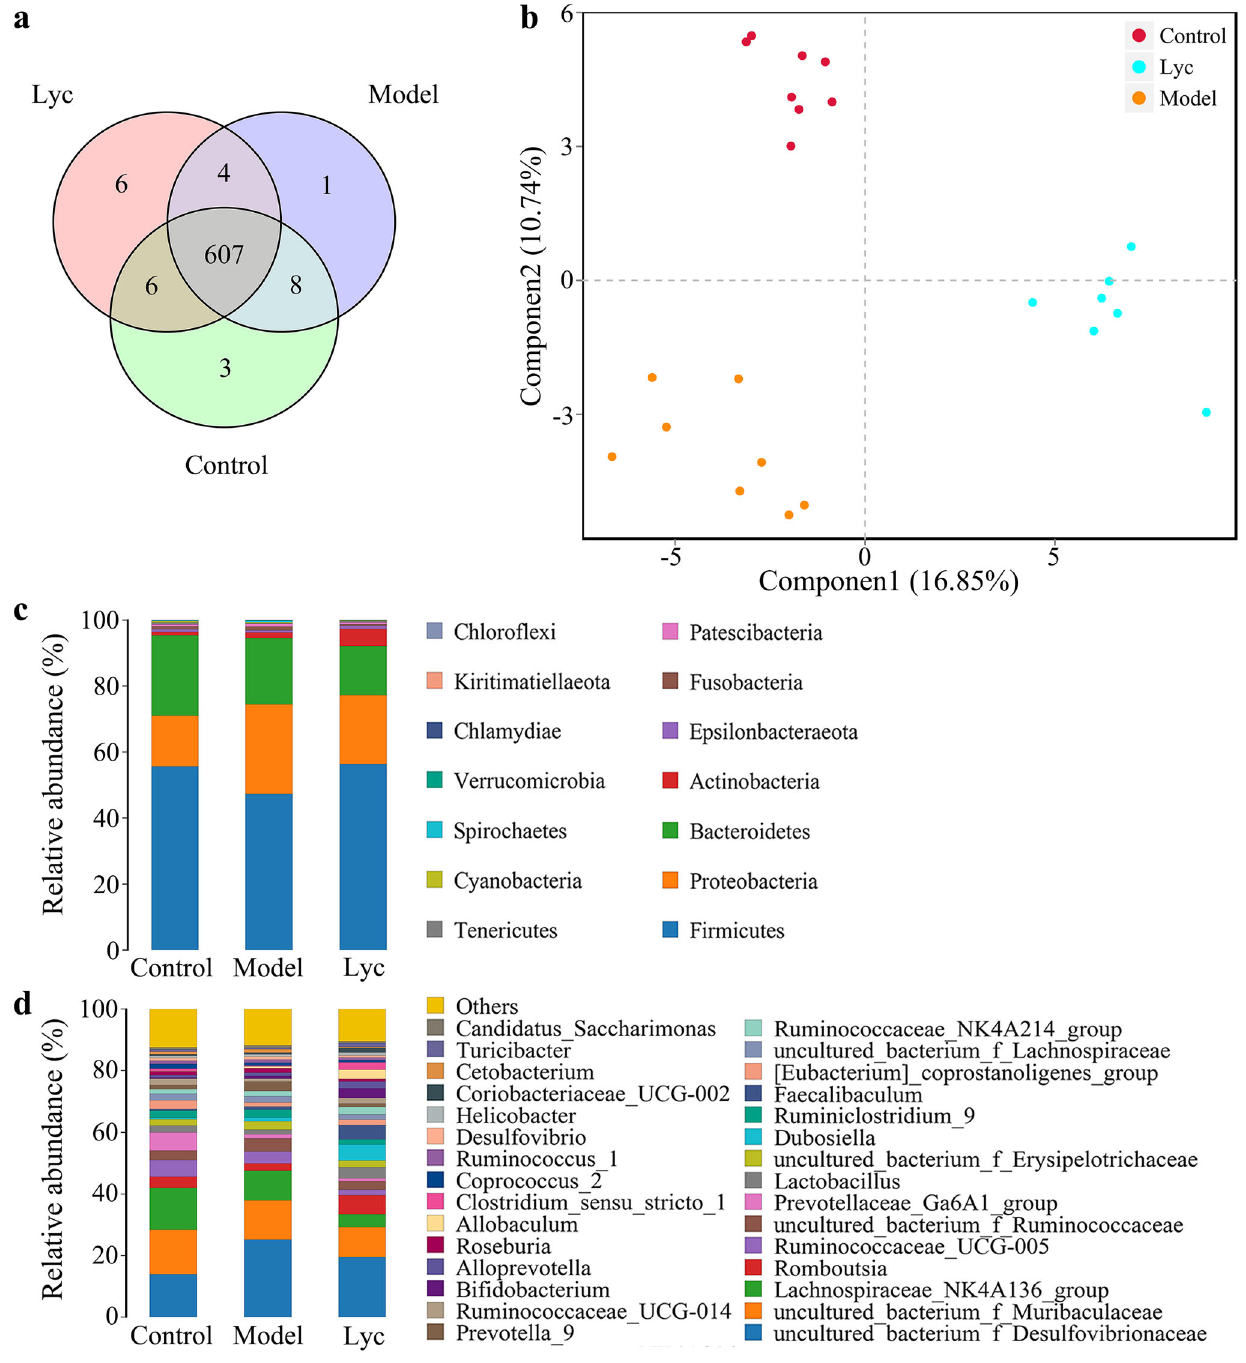
Fig. 3 Metagenomics information of intestinal micro fl ora among the Control, Model and Lyc group. a The Venn diagram on the OTU level among groups. b PLS-DA plot among groups. c The relative abundance of micro fl ora on the phylum level and d on the genus level ( n = 8 for Control and Model group, n = 7 for Lyc